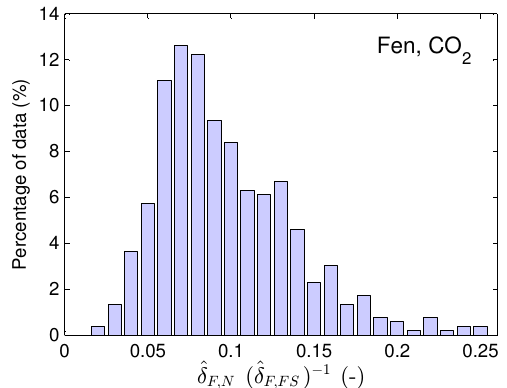
Figure 5. Frequency distribution of the ratio between the flux in- strumental noise error (the error estimate ˆ δ F,N ) and total flux uncer- tainty (the error estimate ˆ δ F,FS ) . CO 2 data measured at the fen site with SNR<3 (see Sect. 4.3.1) were used in the